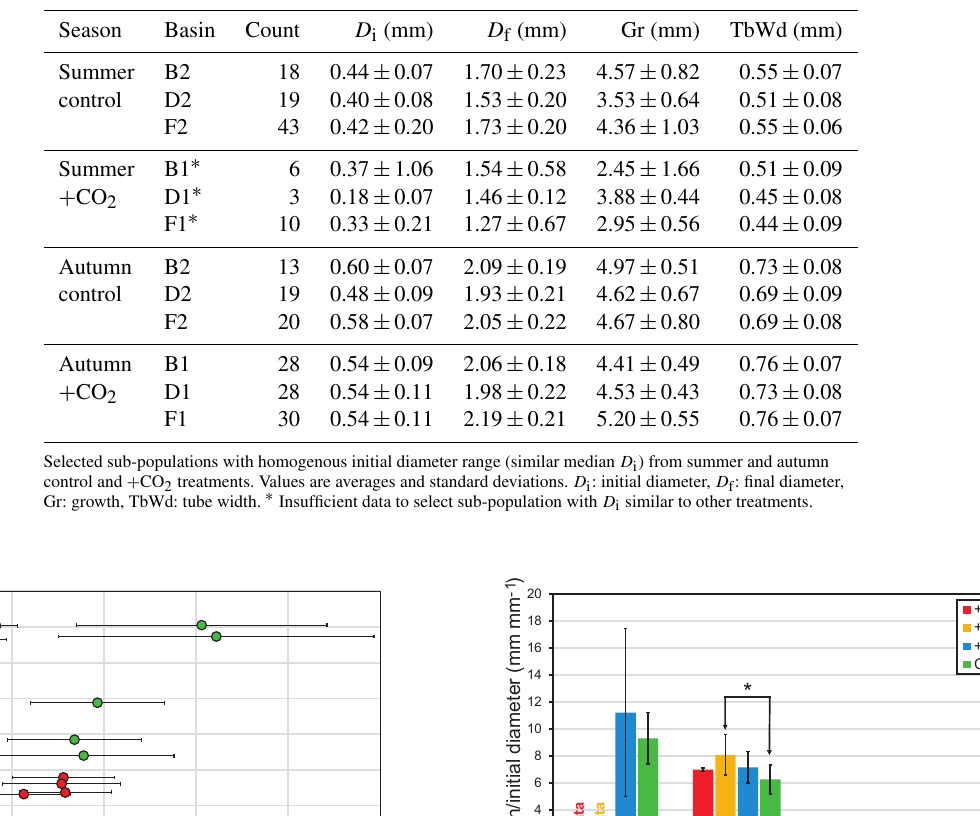
Table 3. Mean size and growth parameters of juvenile S. spirorbis populations in summer and autumn.